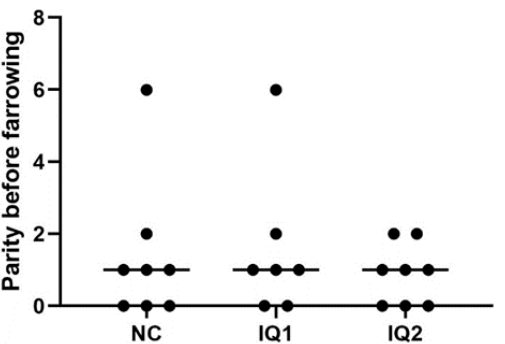
Figure 1. Parity of sows, before the farrowing, included in the experiment. Sows received either a basal diet (NC), or supplementation with isoquinoline alkaloids (IQ) during gestation and lactation (IQ1), or only during the lactation period (IQ2).